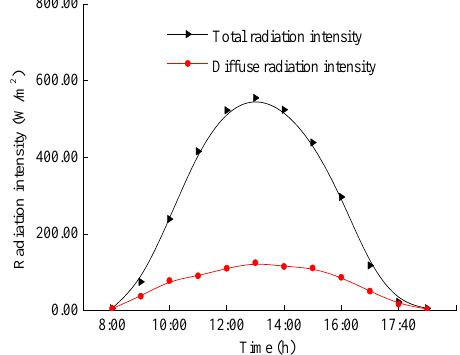
Figure 7. Solar radiation intensity outside the residential building.